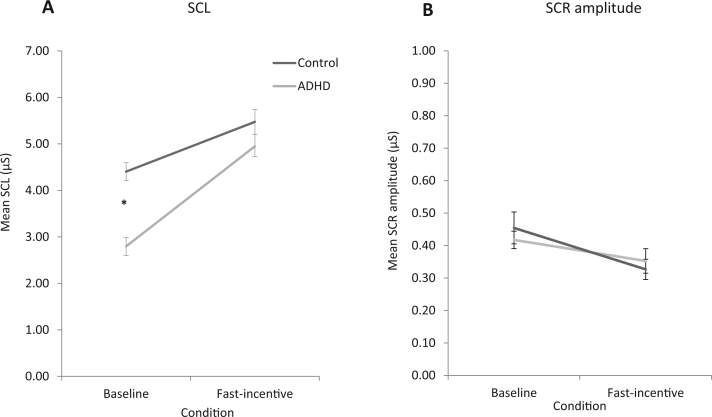
Skin conductance variables [(A) skin conductance level (SCL) and (B) skin conductance response (SCR) amplitude] measured in control (black) and attention-deficit/hyperactivity disorder (ADHD; gray) groups during performance on the baseline and fast-incentive conditions of the Fast task. *p < .05 significance.